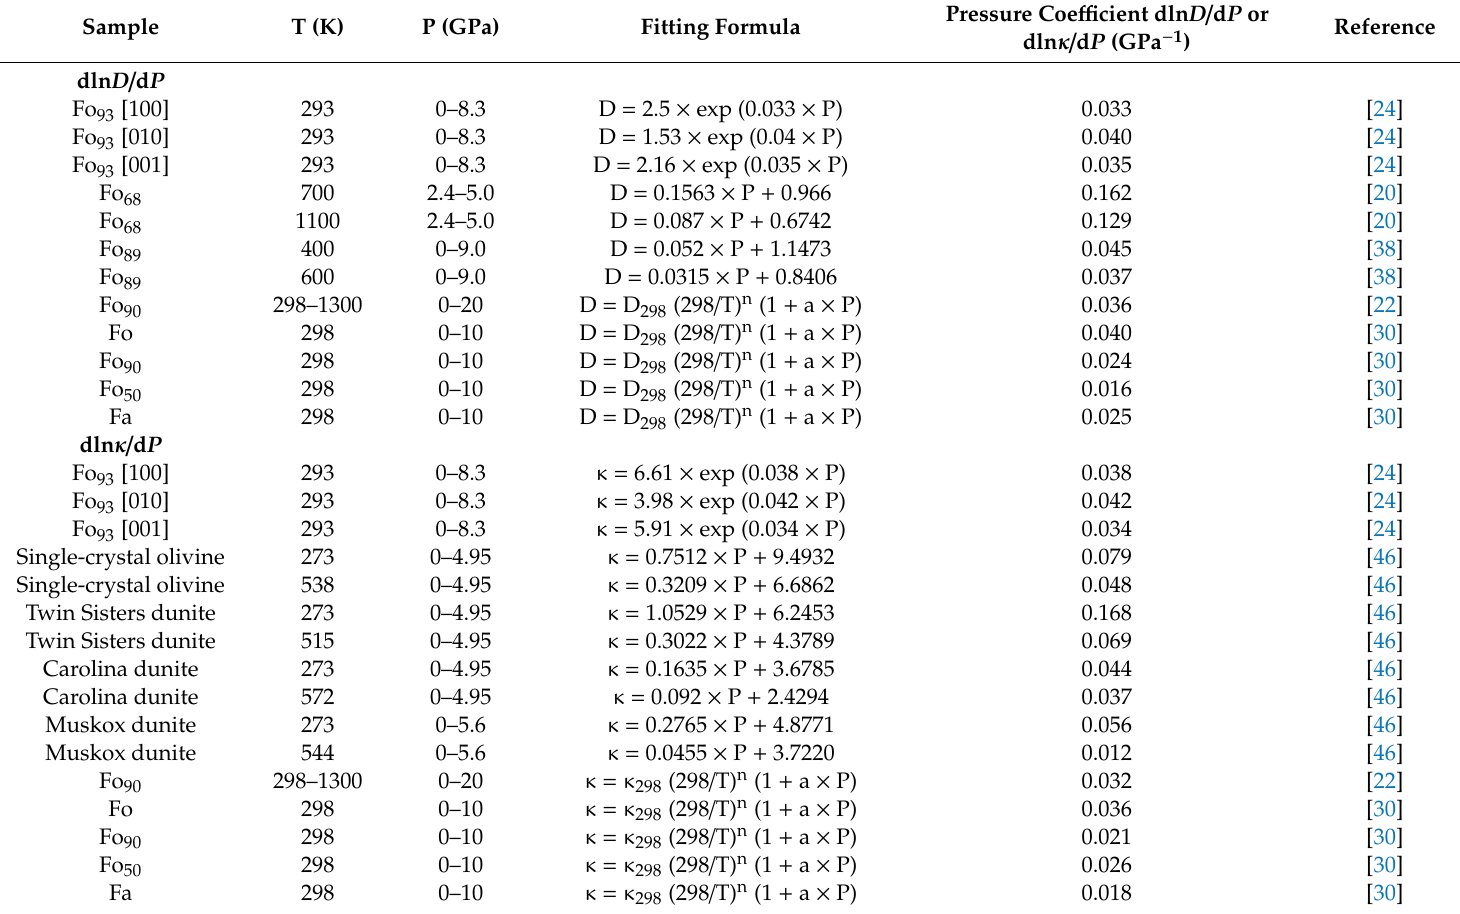
Table 3. The summary of the pressure coe ffi cients (dln D / d P or dln κ / d P ) for olivine at normal pressure and